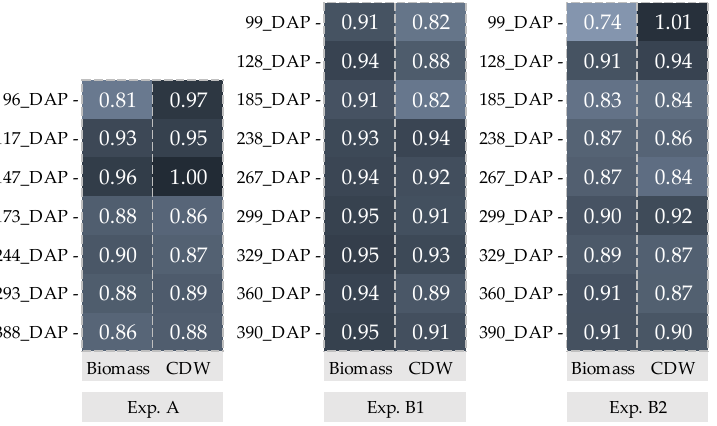
Figure 5. Heat maps of CV RMSSE values of the emulators built for biomass and CDW at each reporting frequency of three experiments: Experiment A, Experiment B1 and Experiment B2. Color ranges from dark blue to light blue represent values from 1 to lower values and 1 to higher values.